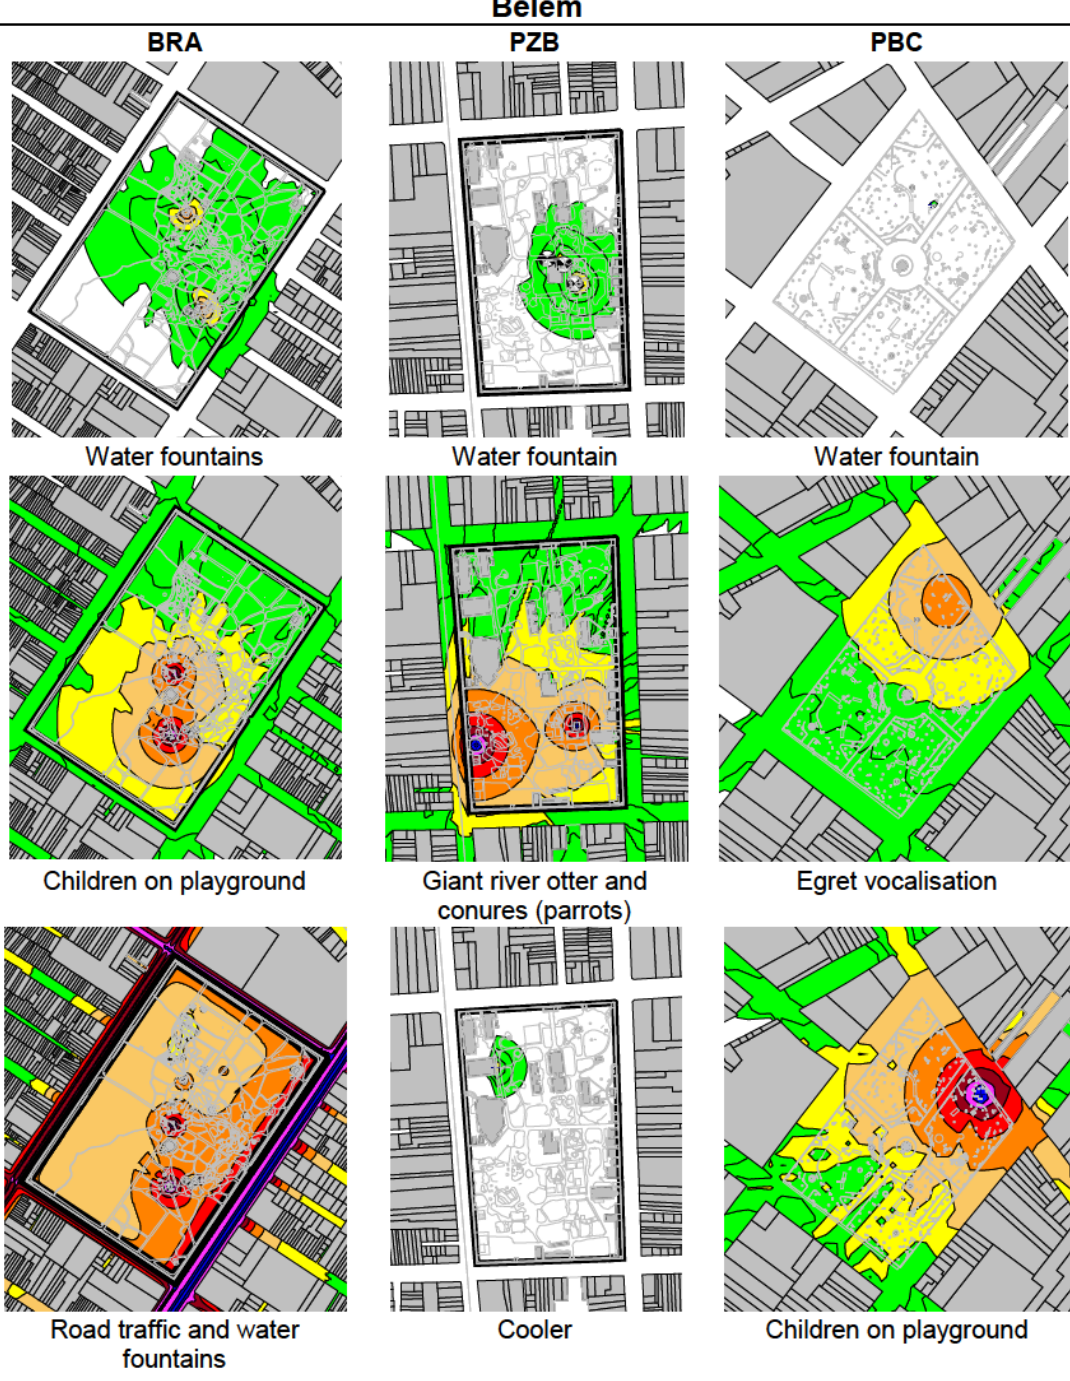
Figure 6: Audibility maps of main sound sources in Belém parks.